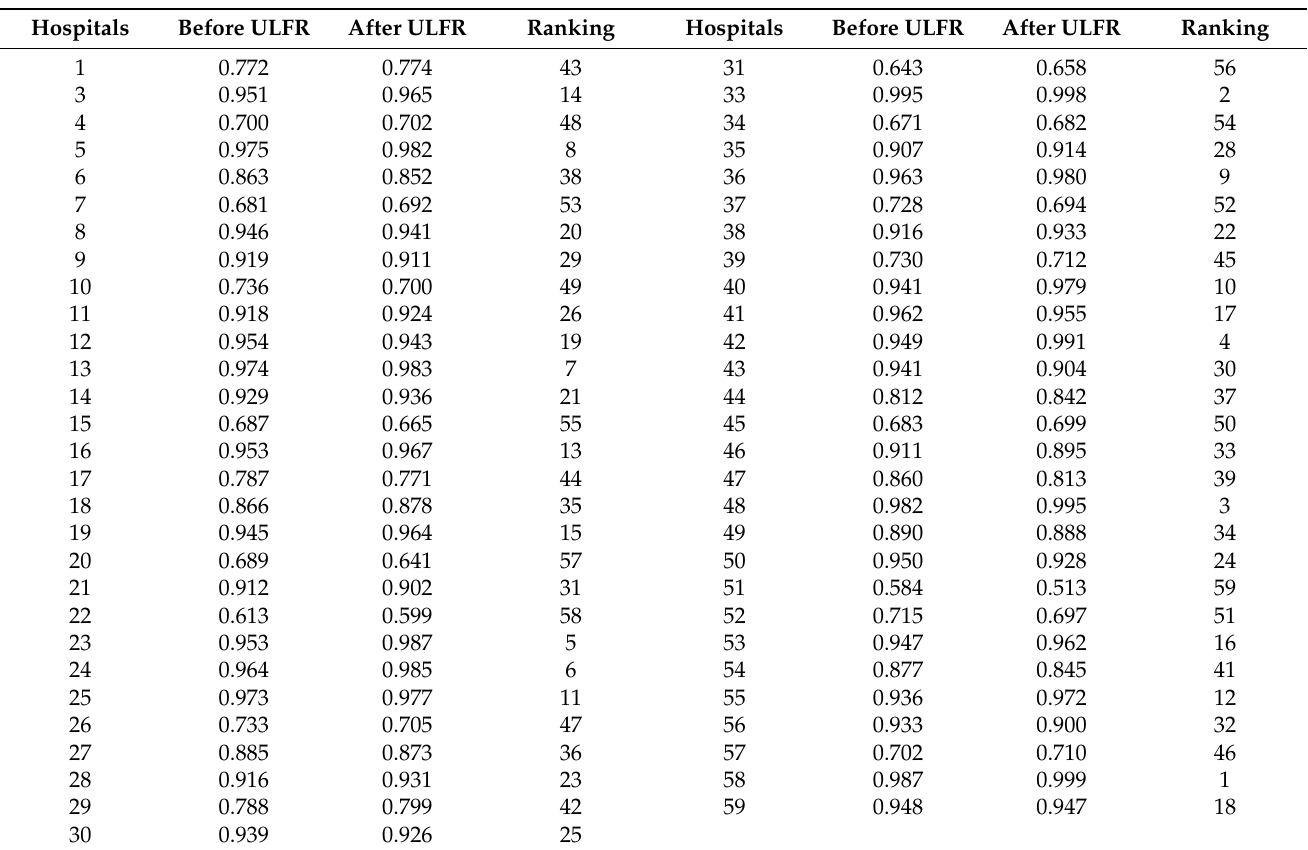
Table 6. Efficiency assessment of the hospitals for proposed hybrid VCS model before using ULFR, after using ULFR and final ranking after applying